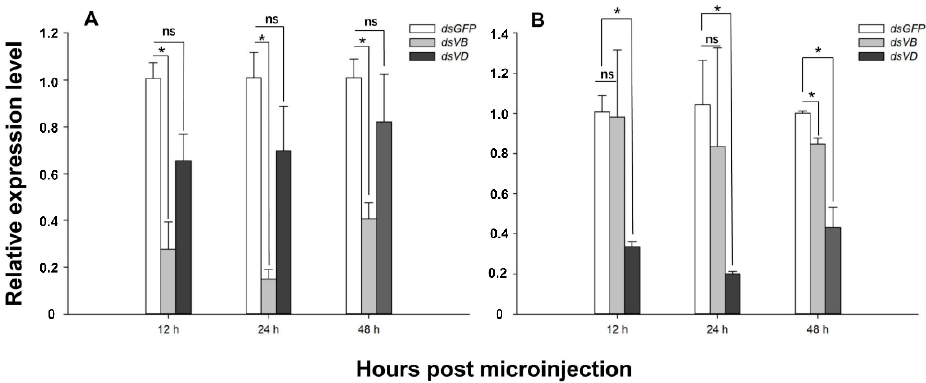
Figure 3. Abundance of V-ATPase B and V-ATPase D transcripts in L. trifolii after microinjection with dsRNA. Adults were injected with 100 ng dsV-ATPase B , dsV-ATPase D , or dsGFP (control), and expression was measured at 12, 24, and 48 h. Panels: ( A ) V-ATPase B and ( B ) V-ATPase D expression. Data were analyzed by the Student’s t -test, p < 0.05. Asterisks represent significant differences between control and RNAi treatment; ns indicates no significant differences.